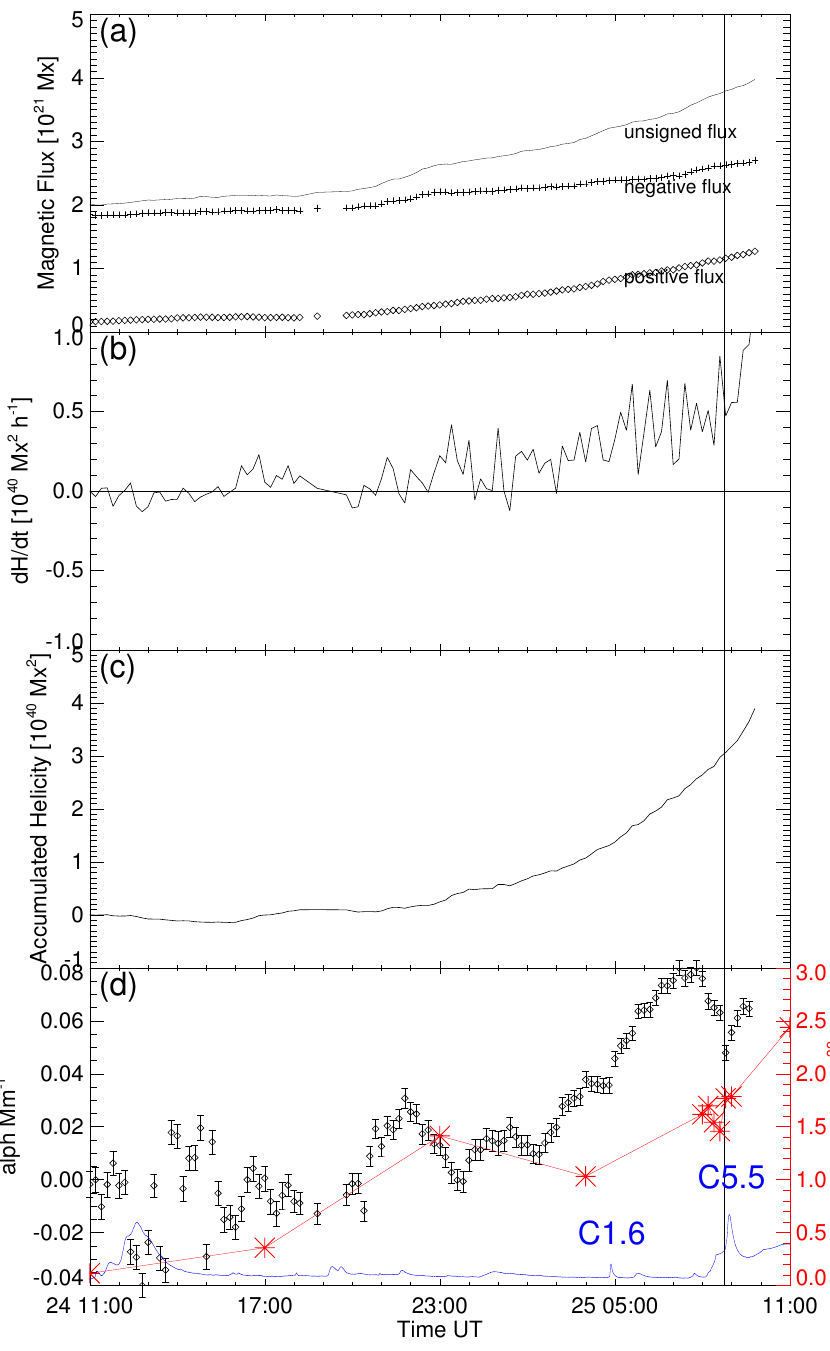
Figure 10. Temporal evolution of ( a ) unsigned flux (black line), negative flux (plus) and positive flux (diamond); ( b ) transport rate of magnetic helicity; ( c ) accumulated helcity; ( d ) α total (black diamond), E free (red star) and GOES flux (blue